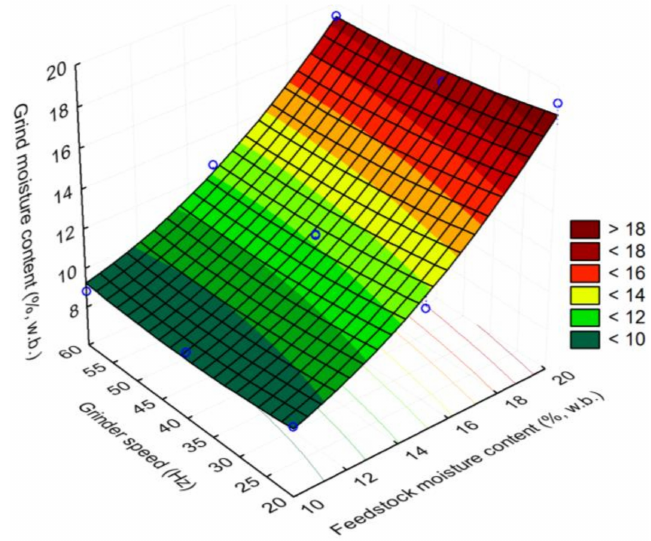
Figure 13. The effect of feedstock moisture content and grinder speed on grind moisture